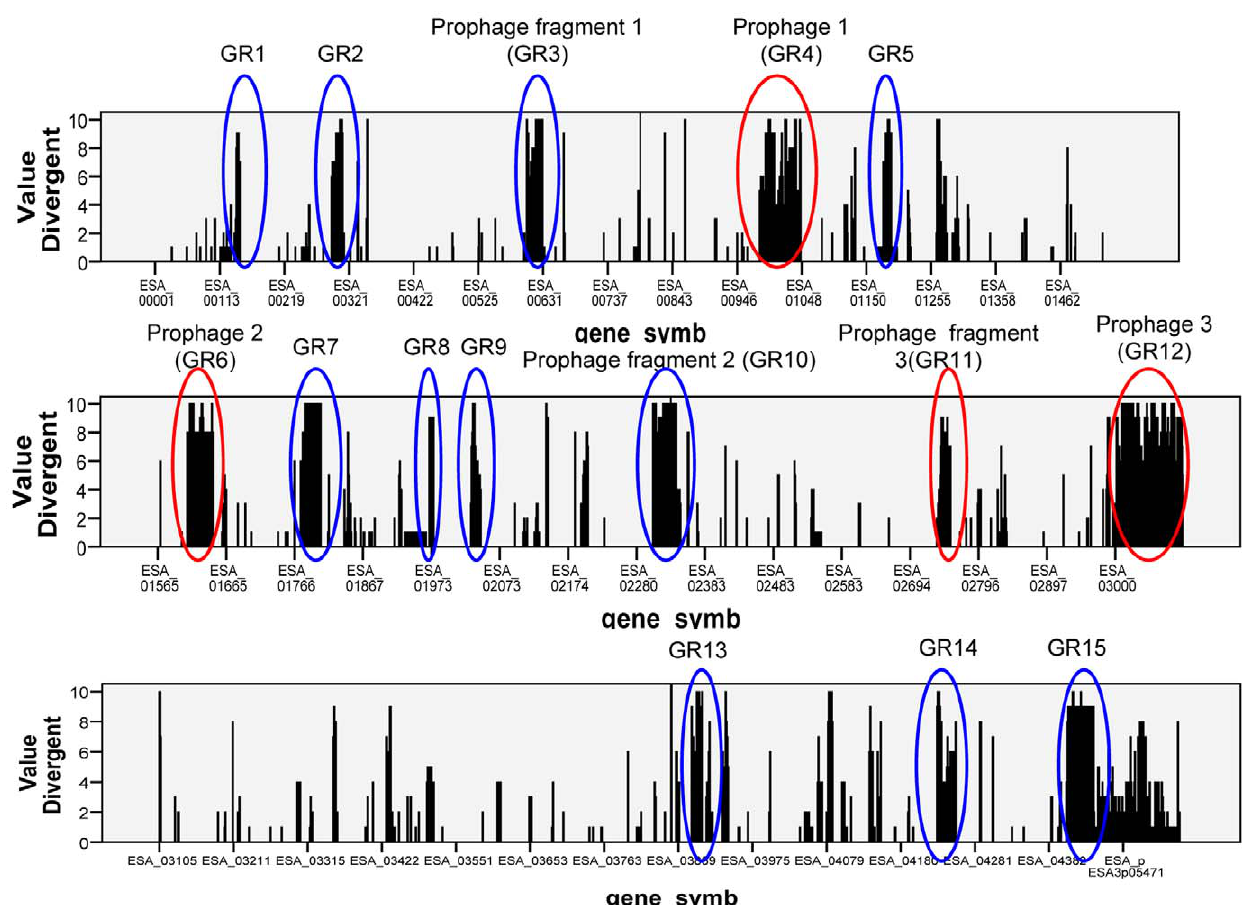
Figure 2. Distribution of the 15 variable regions across the C.sakazakii BAA-894 genome. Each column represents a gene classified as absent by CGH analysis in at least one strain. The height of the columns indicate the number of strains (out of 10) in which the gene was found to be absent. The major variable regions (blue) and prophages (red) are indicated in order of their appearance in the genome of C. sakazakii BAA-894.